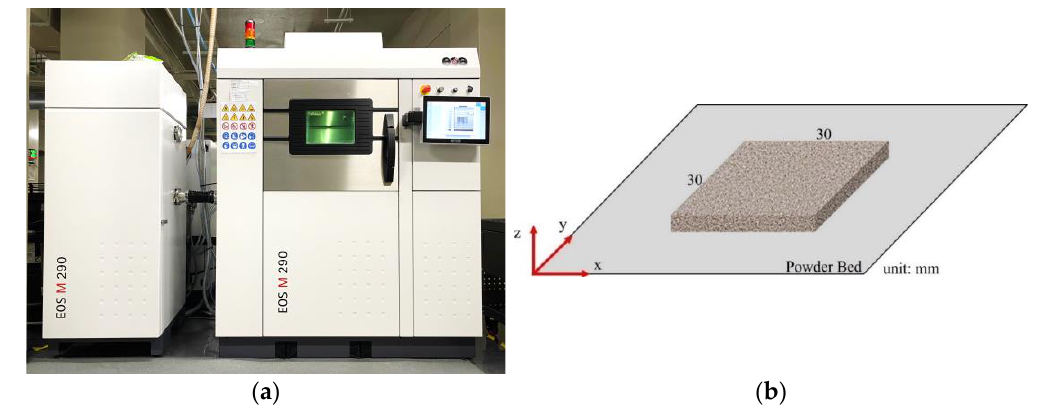
Figure 1. ( a ) EOS M290 SLM equipment and ( b ) schematics of SLM cellular parts. Table 2. SLM parameters of 17-4 PH, Inconel 718, and Ti-6Al-4V ELI porous material.